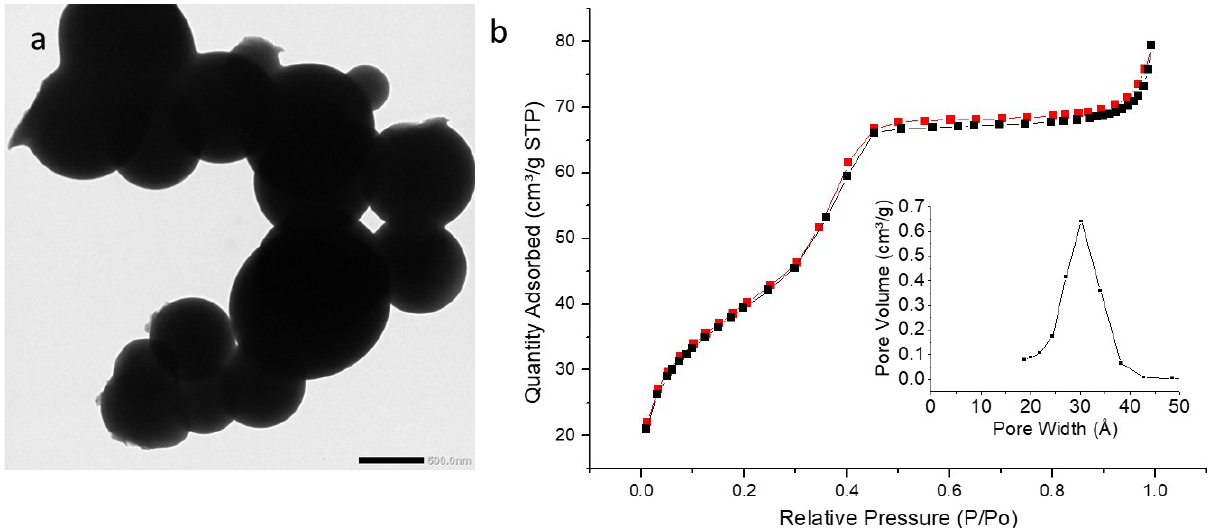
Figure 13. ( a ) TEM image of EtbiPyPMO 6 scale bar 500 nm. ( b ) Nitrogen adsorption–desorption at